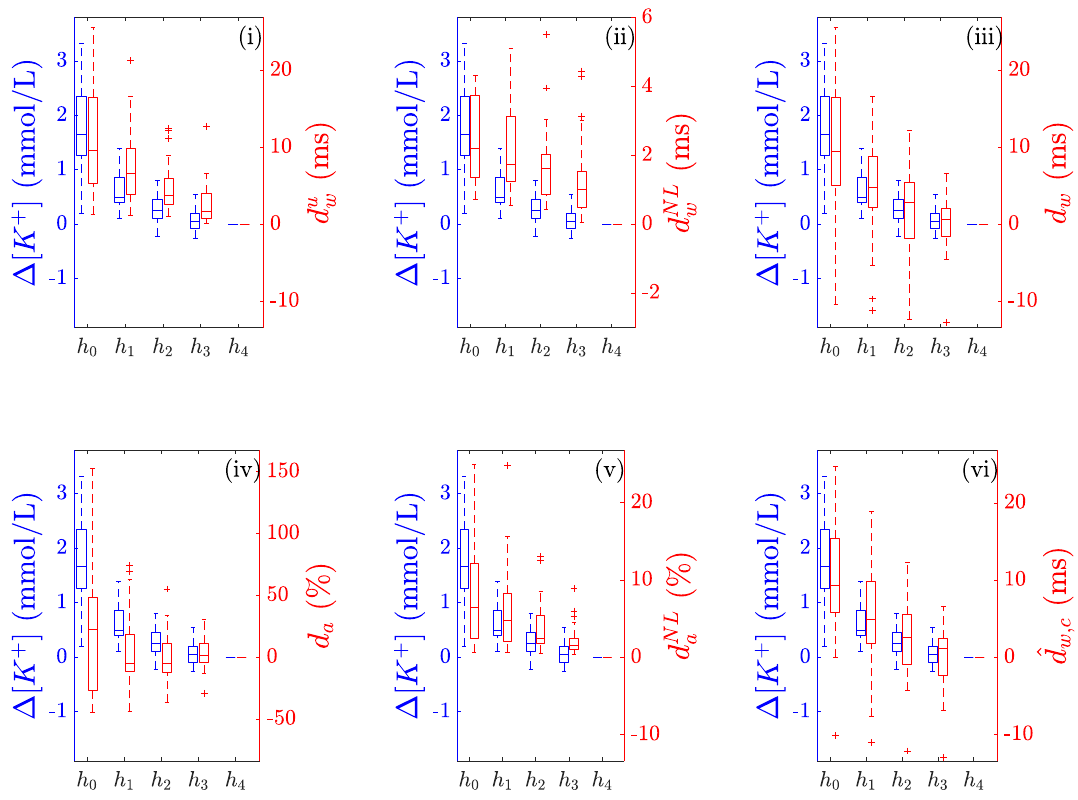
Figure 4. Boxplots showing the distribution of (cid:31) [ K + ] (blue) and all the described PCA-based time-warping ˆ d biomarkers ( d u w , d a , d NL w , d NL a , d w , and w , c ) (red), computed at different time points from the beginning, h 0 , to the end, h 4 , of the HD session ( h 0 to h 4 in Fig. 1). (cid:31) [ K + ] was computed as in (23). + denotes outliers.